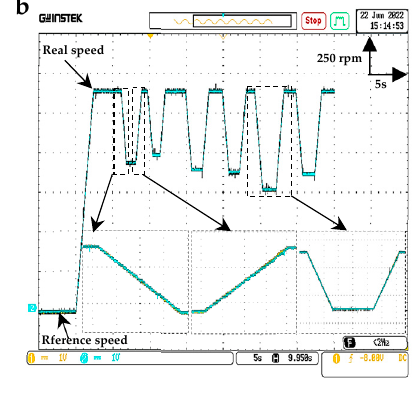
Figure 17. Speed response for speed profile 1 and 2.